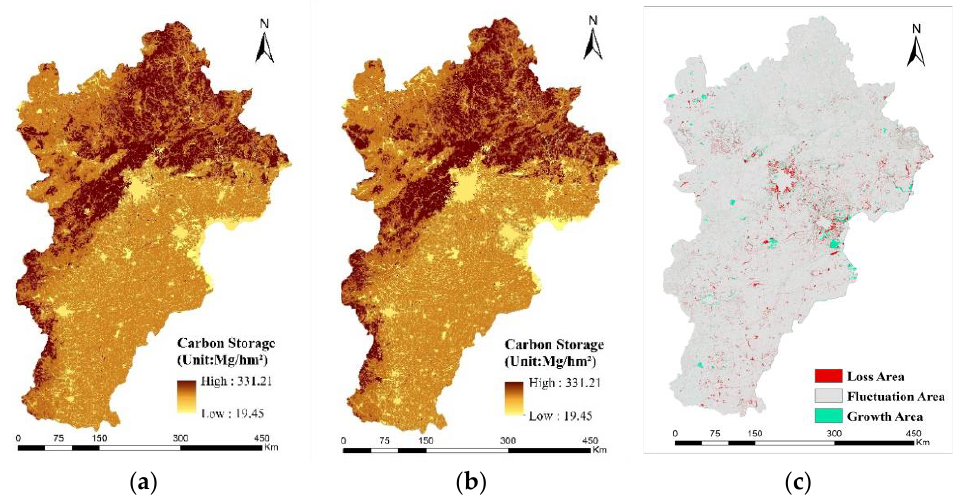
Figure 3. Spatial distribution or variation of carbon storage in the Beijing-Tianjin-Hebei region from 2010 – 2018. ( a ) Spatial distribution of carbon storage in 2010, ( b ) Spatial distribution of carbon storage in 2018, and ( c ) Spatial distribution of carbon storage loss from 2010 to 2018.